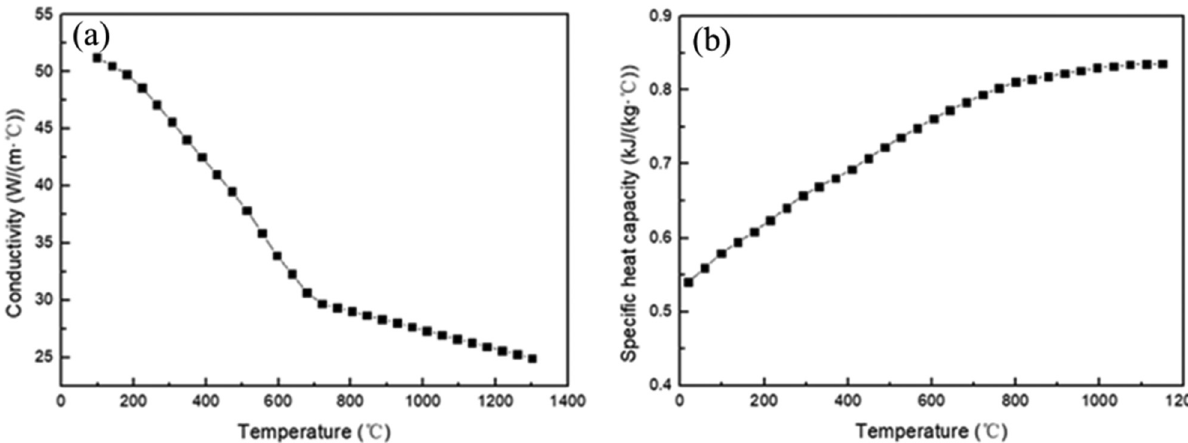
Figure 2: Variation of thermophysical parameters of compacted graphite iron with temperature: ( a ) thermal conductivity; ( b ) speci fi c heat capacity.